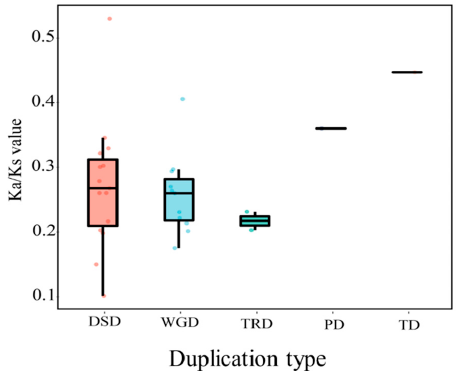
Figure 4. Different models of gene duplication in the LbaBBX family. The x -axis represents the duplication type. The colorful dots represent duplicated gene pairs. Whole genome duplication (WGD), tandem duplication (TD), proximal duplication (PD), transposed duplication (TRD), and dispersed duplication (DSD).